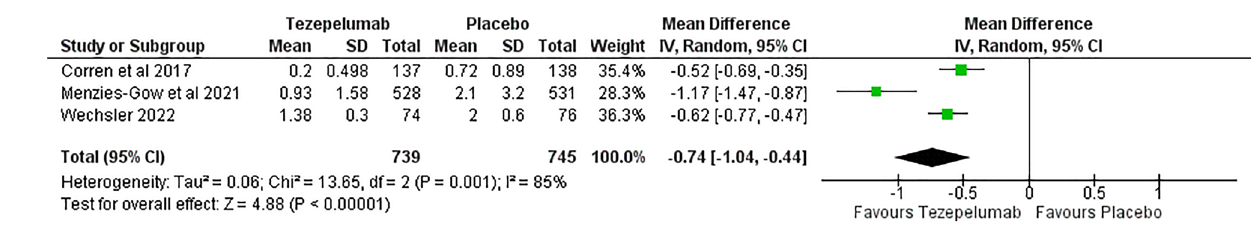
Figure 4. Annualized asthma exacerbation rate (AAERR).